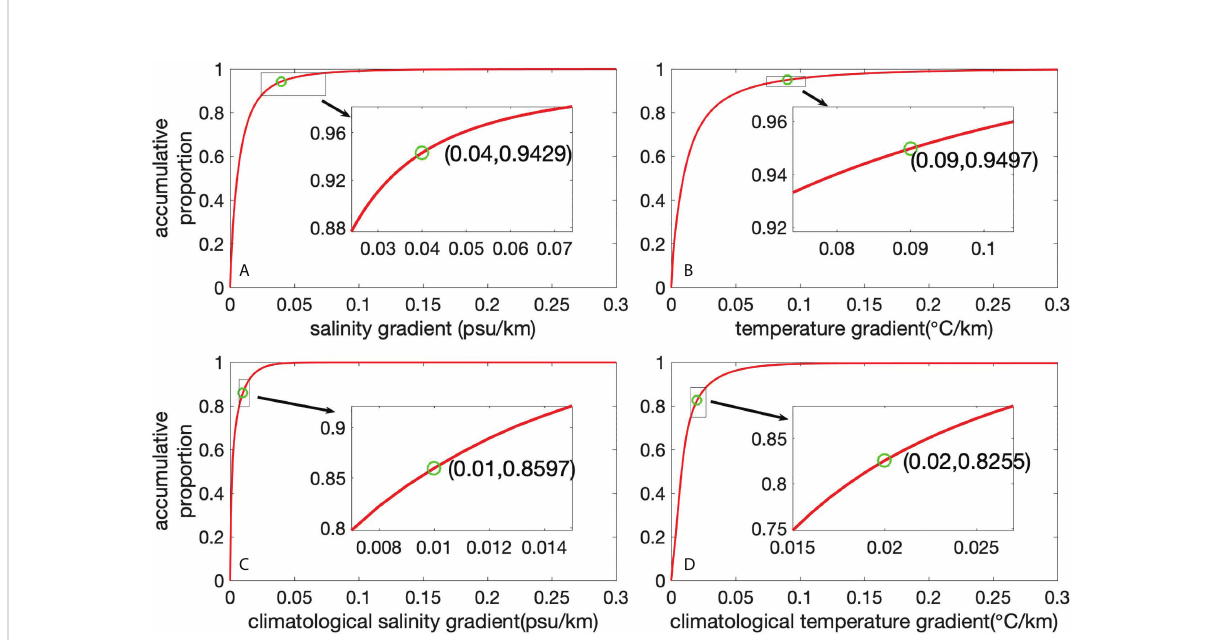
FIGURE 3 Thresholds. Grid point number accumulative curves of (A) 1993 – 2018 salinity gradient, (B) 1993 – 2018 temperature gradient, (C) climatological salinity gradient, and (D) climatological temperature